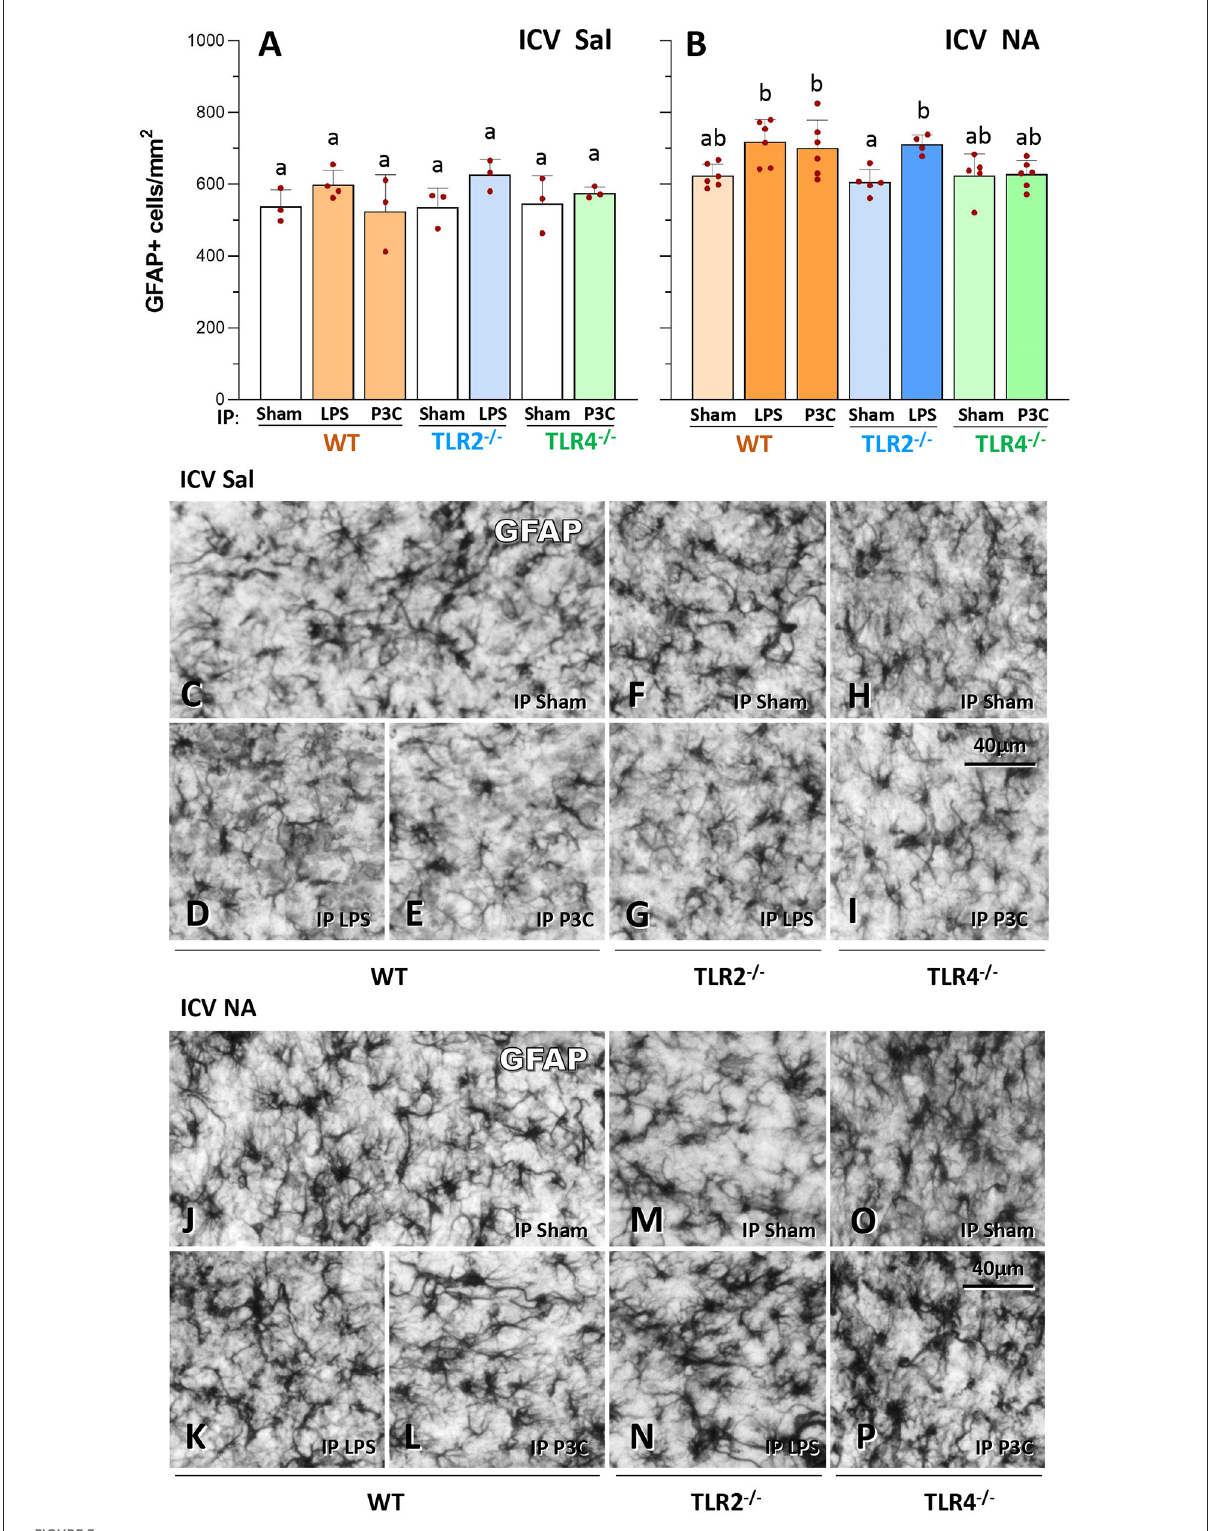
FIGURE3 GFAP-positive cell counts in the hypothalamus of WT, TLR2 − / − and TLR4 − / − mice after a double inflammatory stimulus. The number of GFAP-positive cells (astrocytes) was evaluated in the periventricular region of the hypothalamus (medio-dorsal wall of the third ventricle).